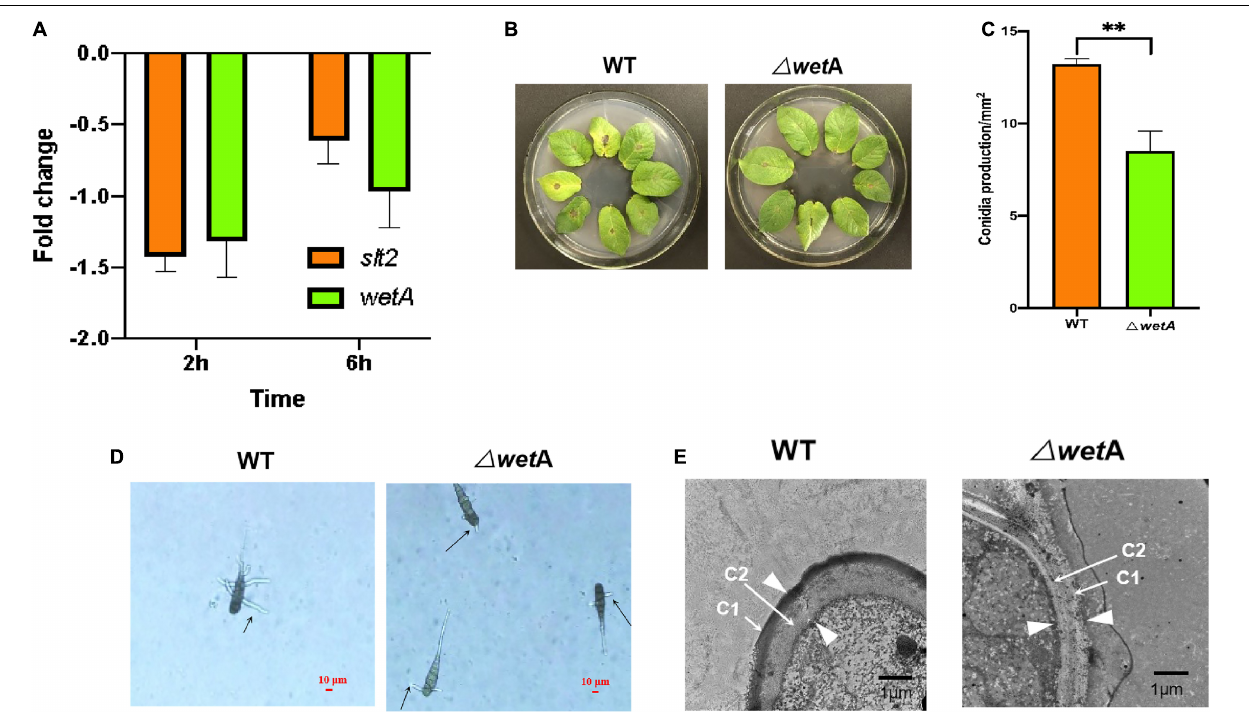
FIGURE 5 | WetA is key conidia-related gene in A. solani . (A) Transcriptional expression profiles of slt2 and wetA after co-culturing with 6-methyl-2-heptanone for 2 and 6 h. (B) Symptoms of early blight disease on potato leaf caused by wild-type A. solani (WT) and mutants ( (cid:49) wetA ). (C) The sporulation yield of WT) and (cid:49) wetA ). (D) The length of (cid:49) wetA mutant and WT germ tubes after a 2-h heat treatment. The “arrows” represented the lengths of (cid:49) wetA mutant and WT germ tubes. (E) Transmission electron micrographs of conidia of WT and (cid:49) wetA . The “arrows” represented C1 and C2 layers respectively; the “arrowheads” represented the width of conidial wall. The results are presented as the means ± SDs ( n = 3). ** above points represent significant differences ( p <